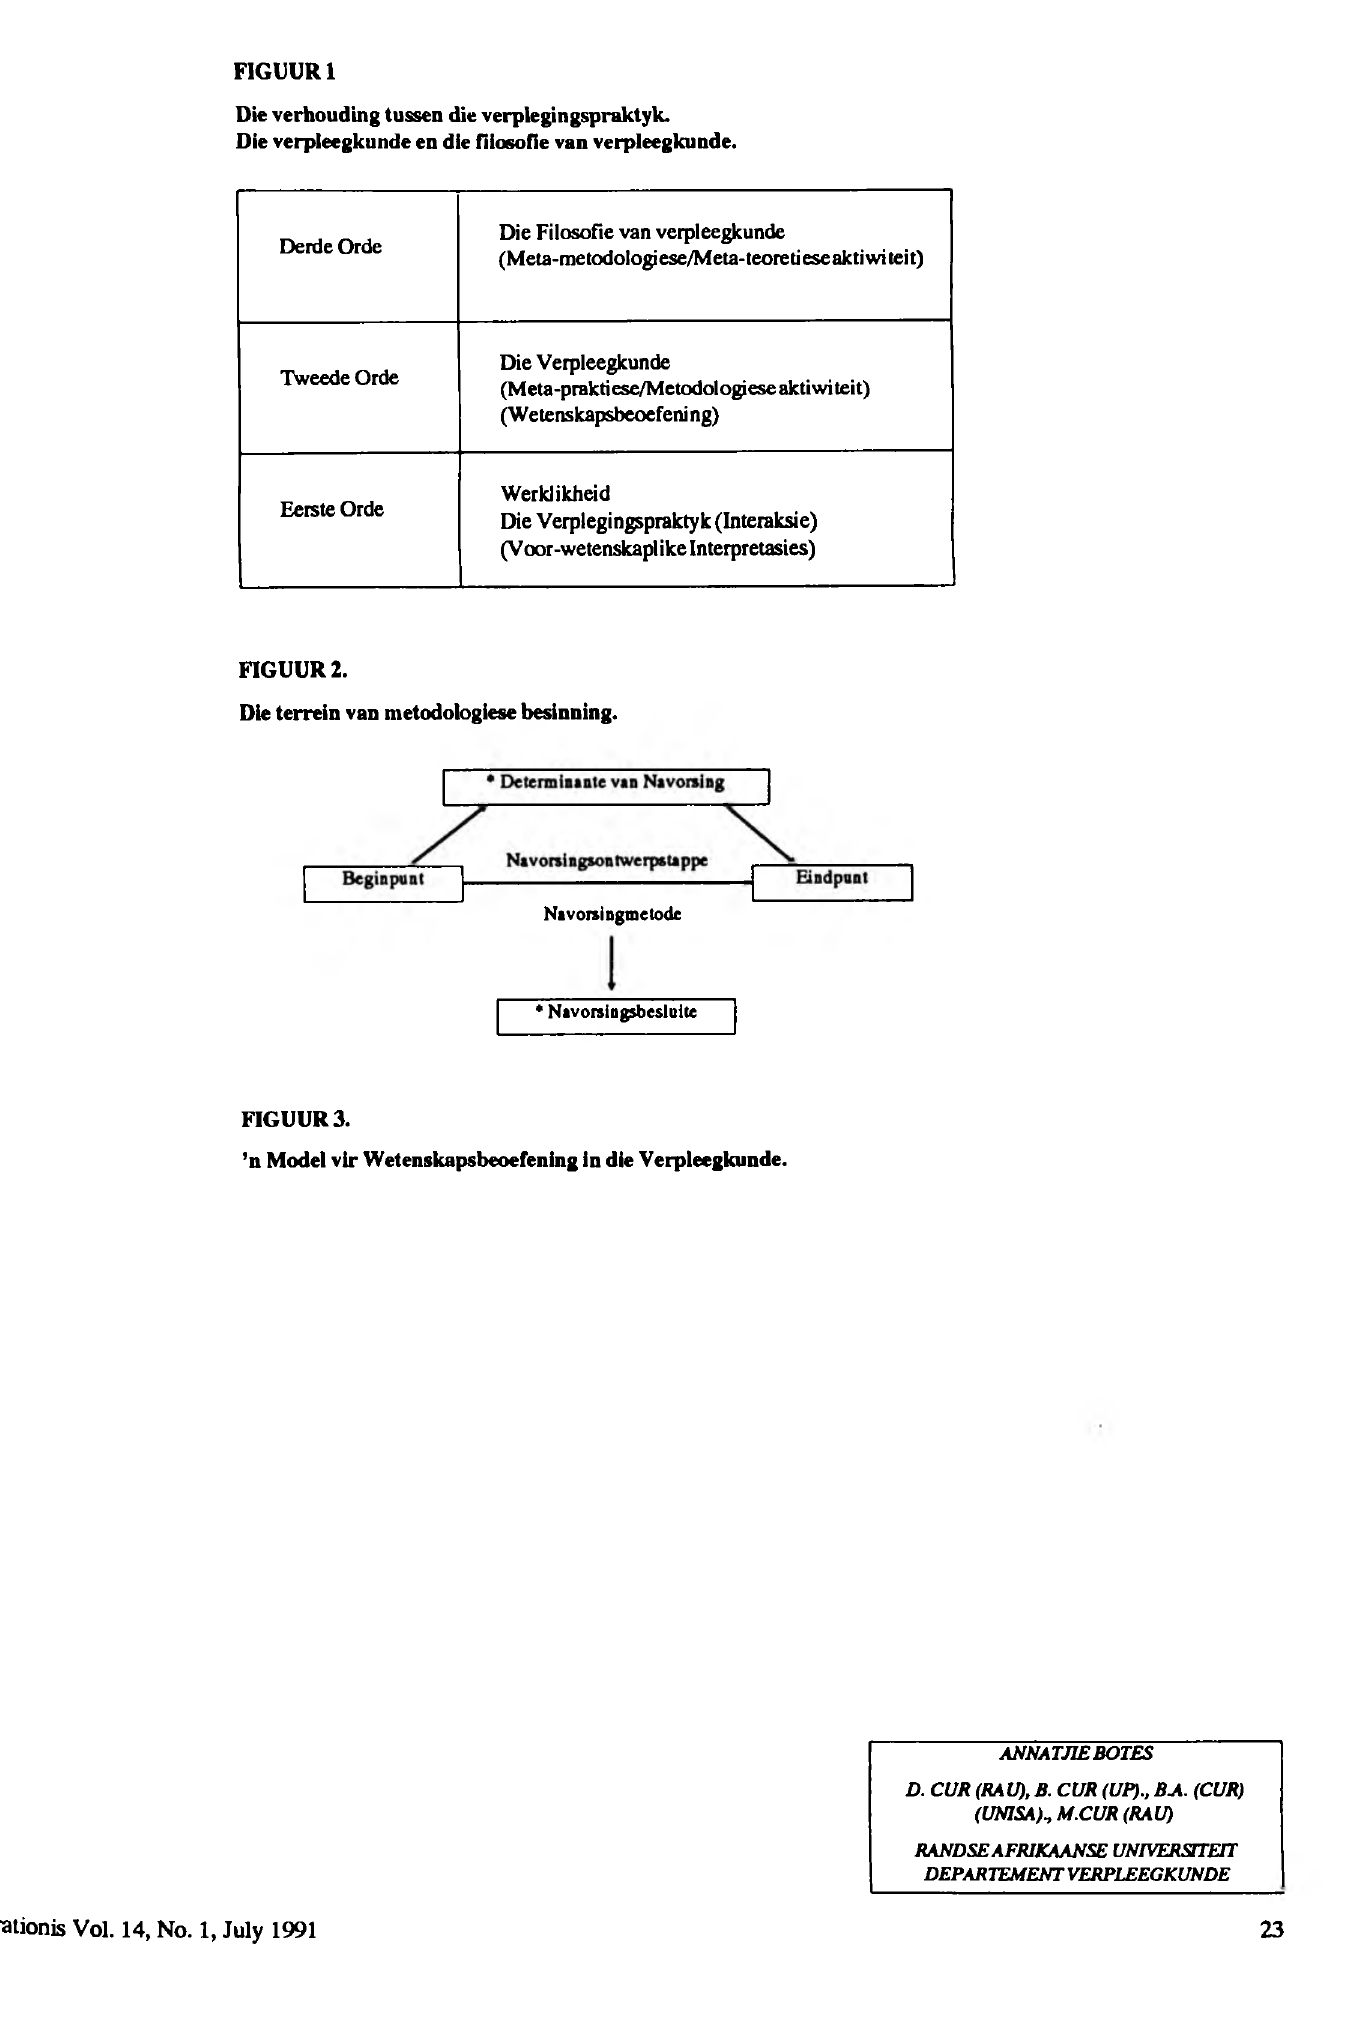
Die verhouding tussen die verplegingspraktyk.